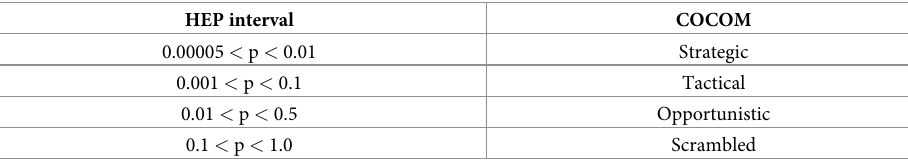
Table 2. HEP interval of each COCOM.